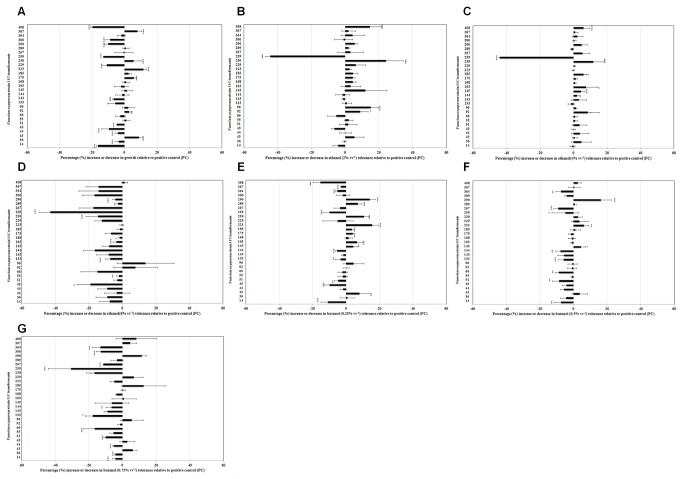
Tertiary screening of Fusarium
oxysporum strain 11C transformants (n=29).Fungi were grown in minimal medium [37] supplemented with; no alcohol (A); 2% (vv-1) ethanol (ethyl alcohol; Sigma, UK) (B), 4% (vv-1) ethanol (C), 6% (vv-1) ethanol (D) or 0.25% (vv-1) butanol (n-butanol; Sigma, UK) (E), 0.5% (vv-1) butanol (F) or 0.75% (vv-1) butanol (G) and incubated at 25°C for 7 days. Percentage increase or decrease in fungal growth relative to the positive control (wild-type strain 11C) was determined. Results represent the mean of three independent experiments and bars indicate SEM. Transformants significantly different from the positive control (wild-type strain 11C) are highlighted with an asterisk (level of significance: <0.050 *, <0.01**, <0.001***).